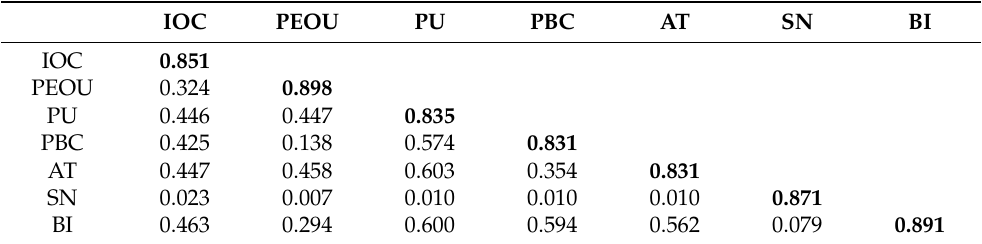
Table 6. Correlation matrix for discriminant